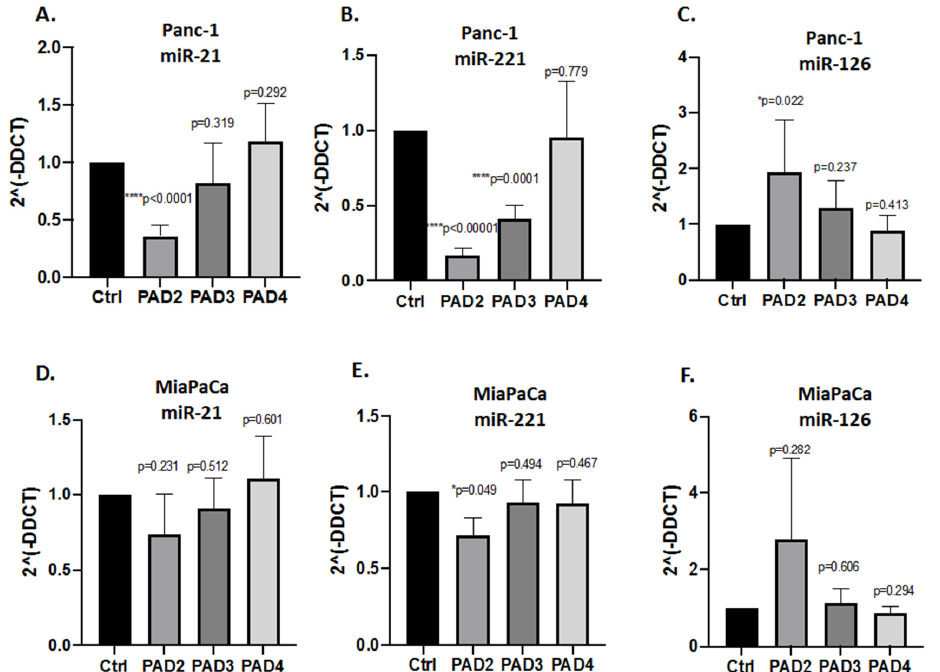
Figure 7. PAD isozyme-specific inhibitor (PAD2, PAD3, PAD4 inhibitor) mediated effects on EV miR cargo in PDAC cells. ( A–C ): Effects on Panc-1 cell-derived EVs for: ( A ) miR21; ( B ) miR221; ( C ) miR126. ( E–F ): Effects on MiaPaCa-2 cell-derived EVs for: ( D ) miR-21; ( E ) miR-221; ( F ) miR-126. Exact p -values are indicated ( * p ≤ 0.05; *** p ≤ 0.001; **** p ≤ 0.0001); error bars indicate